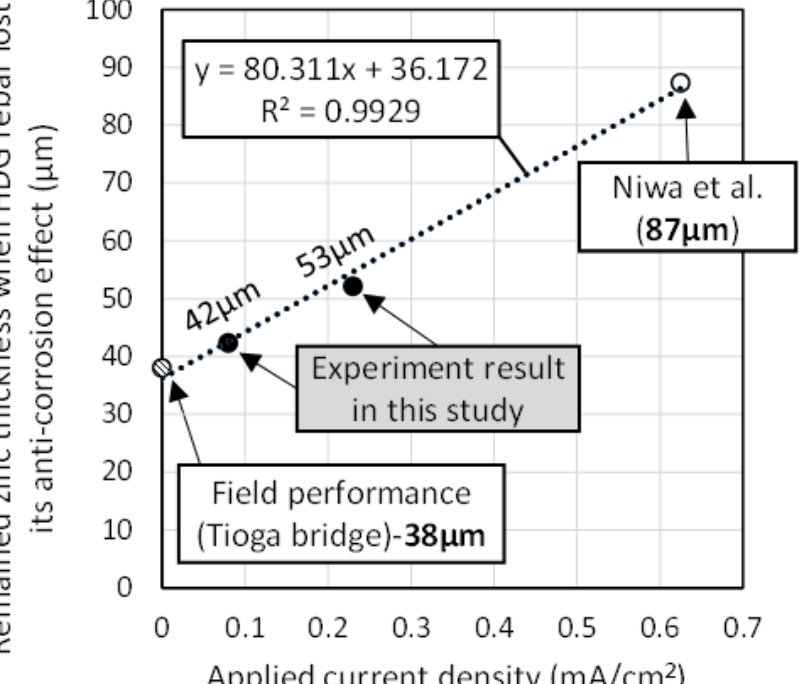
Figure 10. Correlation between the applied current density and the remaining zinc thickness in each corrosion environment (the acceleration test and the field performance).